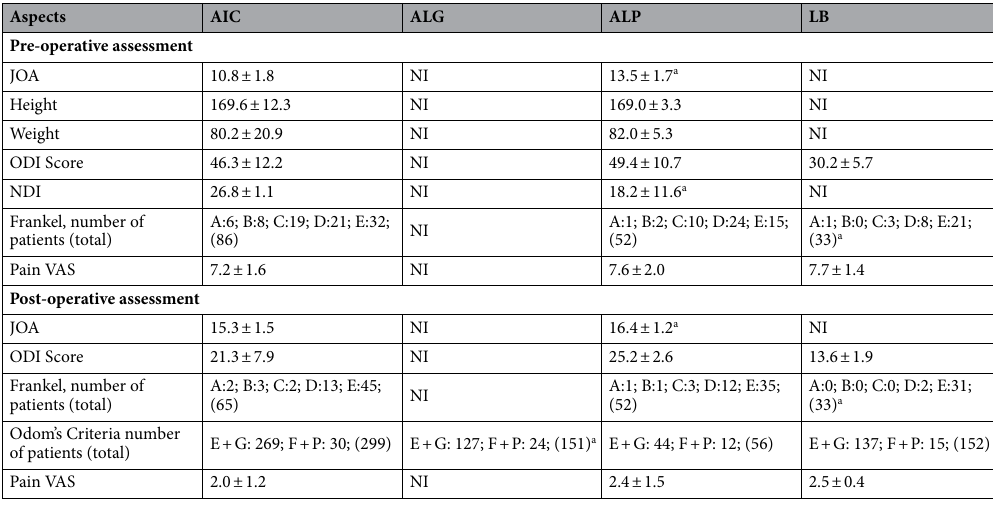
Table 3. Patient’s pre and postoperative assessments. AIC Autologous iliac crest, ALG allograft, ALP alloplastic, LB local bone, NA not applied, NI not informed, VAS Visual Analogue Scale. a Cited in one study.